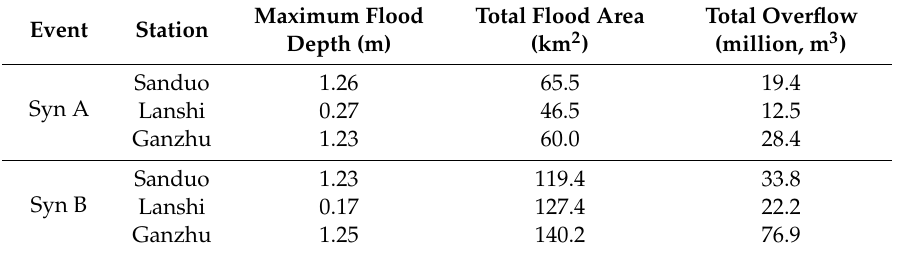
Table 4. Summary of the maximum flood depth, total flood area and volume for the two synthetic events.